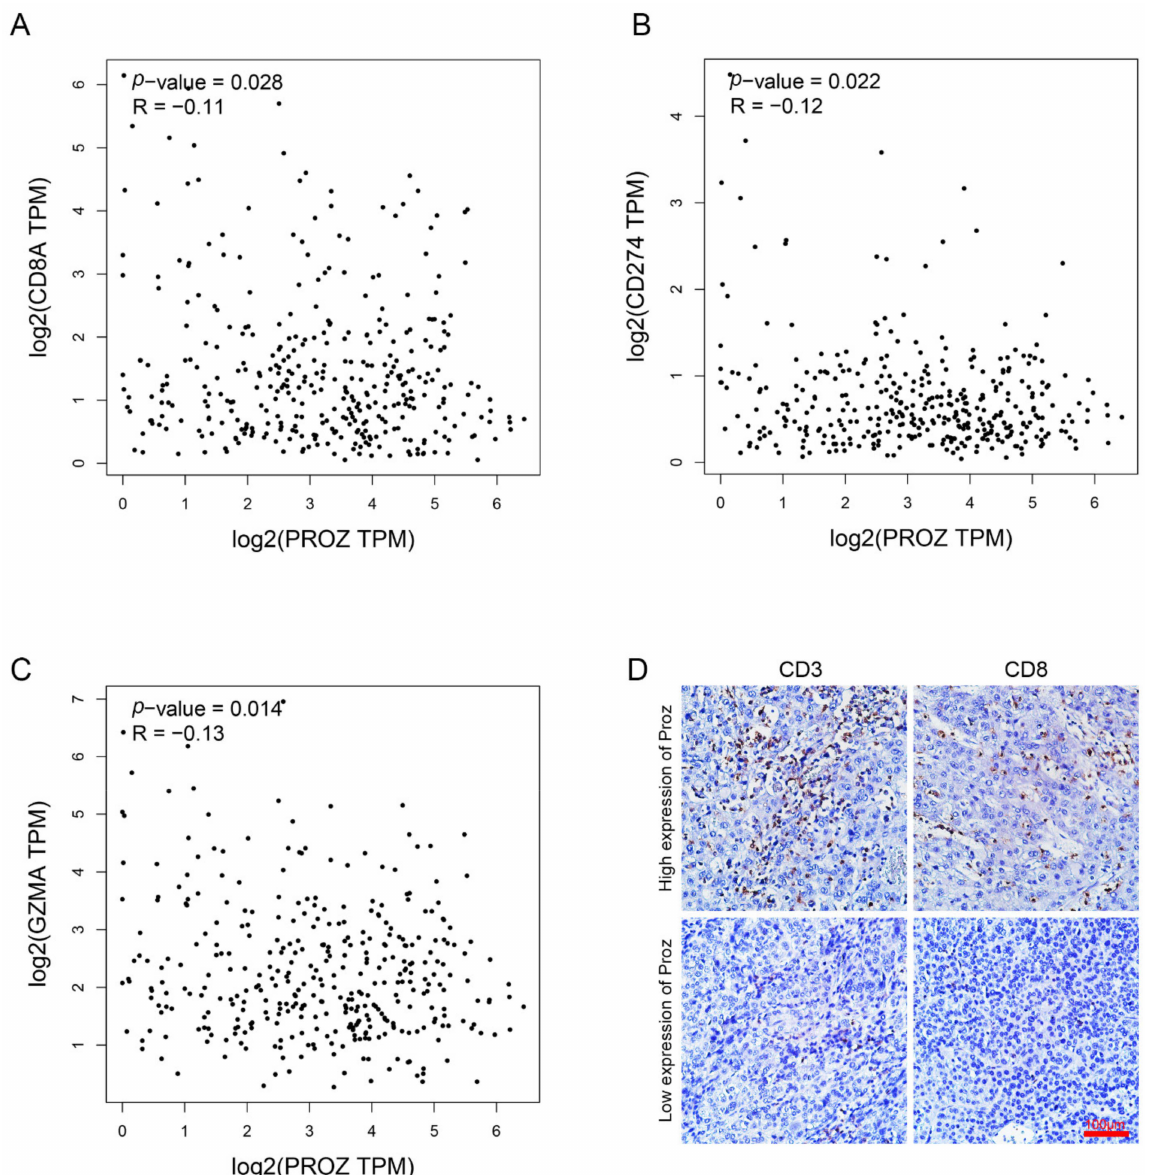
Figure 6. ( A ) Correlation between PROZ gene and CD8A gene was analyzed using TCGA data. ( B ) Correlation between PROZ gene and CD274 gene. ( C ) Correlation between PROZ gene and GZMA gene. ( D ) IHC staining displayed the CD3-positive cells and CD8-positive cells in the tumors expressing high or low